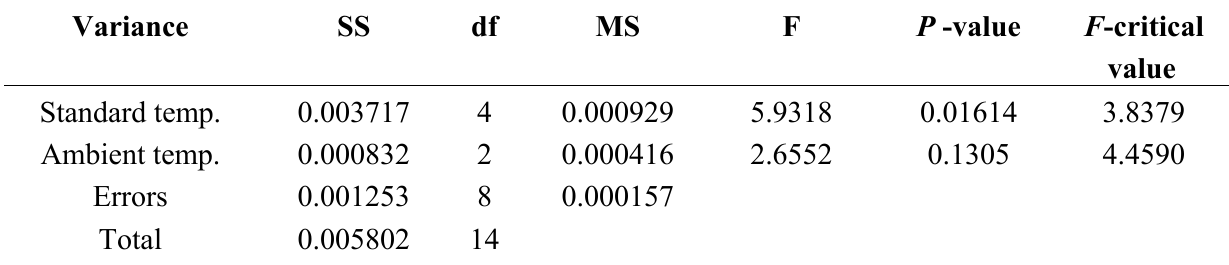
Table 2. Analysis of variance ANOVA table for the effect of standard temperature and ambient temperature on the measurement of OMRON MC-510 thermometer.